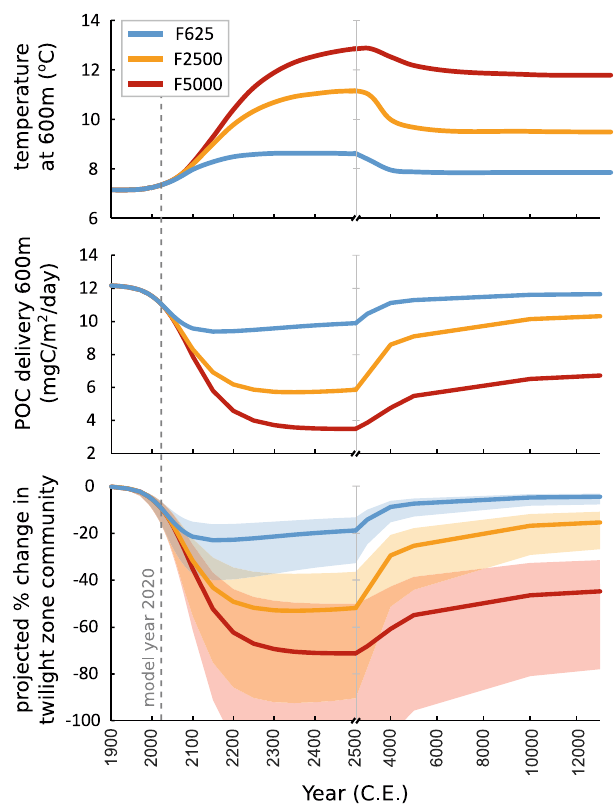
Fig. 5 | Mean low-latitude temperature and particulate organic carbon (POC) delivery at 600m depth and projected change in mid-twilight zone commu- nity. Shaded region in the projected % change in the Twilight Zone community is the uncertainty from the POC-abundance model using one standard deviation (Fig. 4). Note x-axis scale change at 2500C.E. Data for low emissions F625 (blue), mid emissions F2500 (yellow), and high emissions